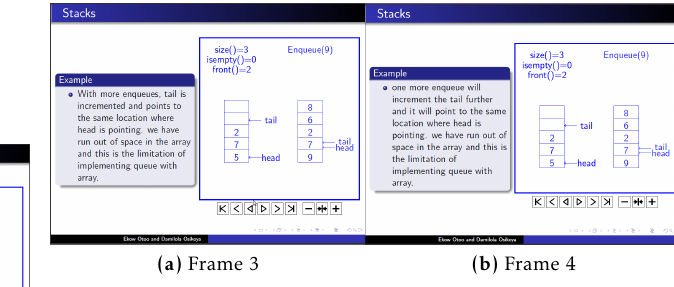
Figure 7. Queue Implementation